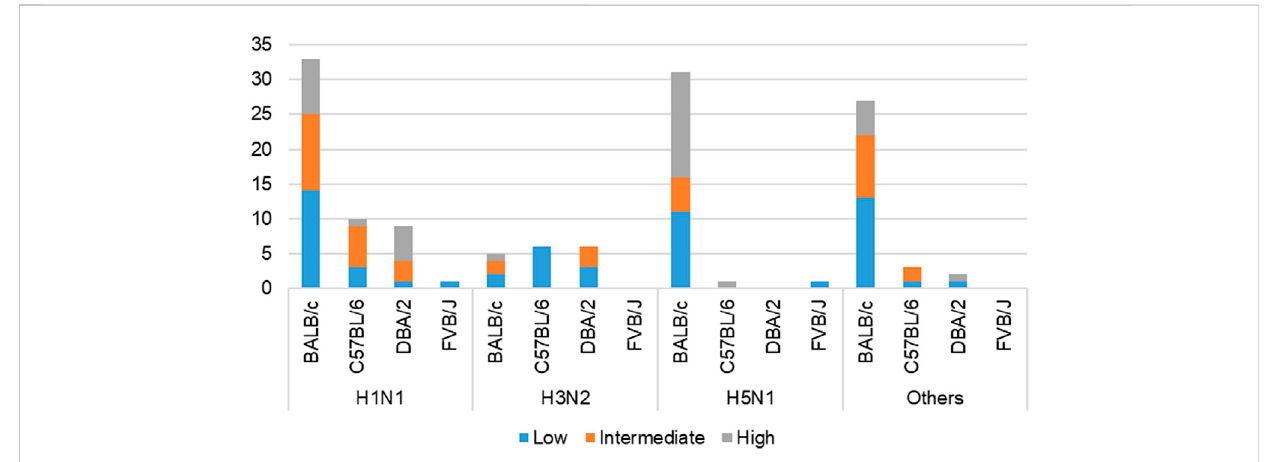
FIGURE 3 Cross-tabulation of IAV subtypes and mouse strains, colored according to three-class virulence classi fi cation problem. ‘ Others ’ refers to the aggregation of infection records from IAV subtypes — H1N2, H3N8, H5N2, H5N5, H5N6, H5N8, H7N2, H7N3, H7N7, and H7N9.